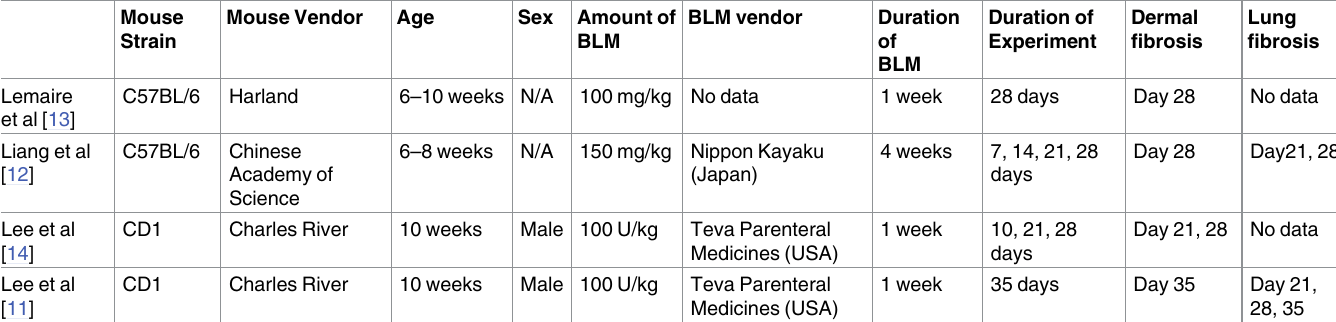
Table 1. Summaryof previous reports describing dermal and pulmonary fibrosis using the pump